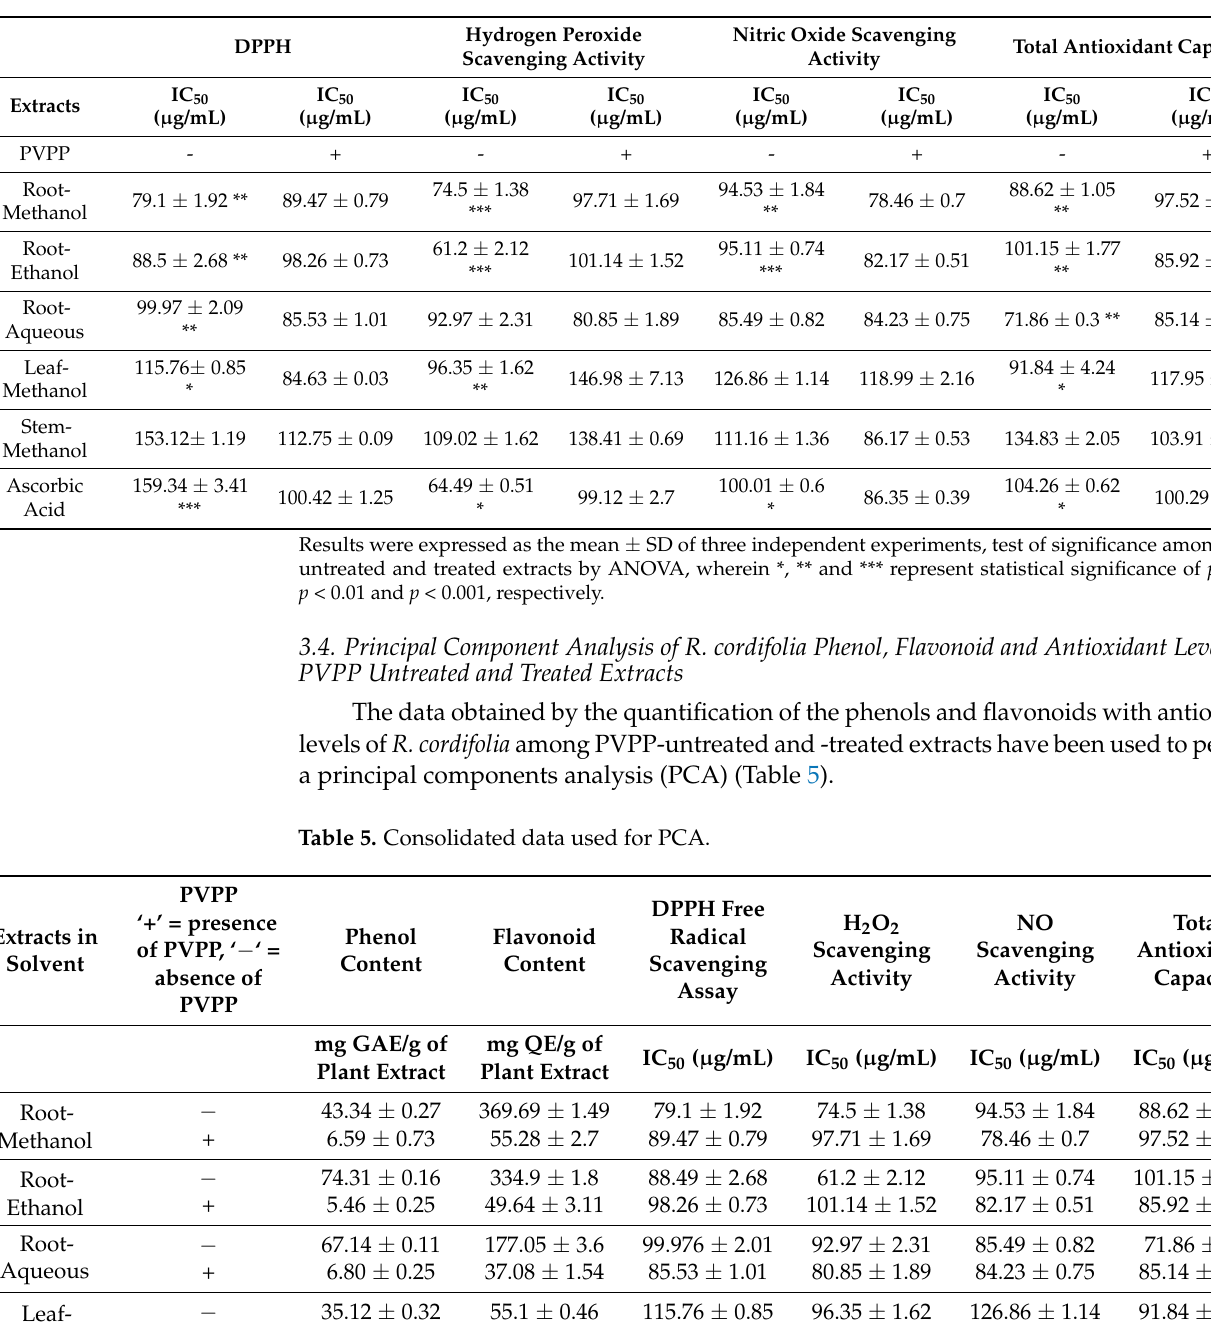
Table 4. IC 50 values of DPPH, hydrogen peroxide, nitric oxide and total antioxidant assay of R . cordifolia . Results were expressed as the mean ± SD of three independent experiments. Significant difference between without PVPP and with PVPP representing p < 0.001, p < 0.01, p < 0.05 is by ***, ** and *, respectively. R. cordifolia extracts were tested at concentrations of 20, 40, 60, 80, 100 µ g/mL.